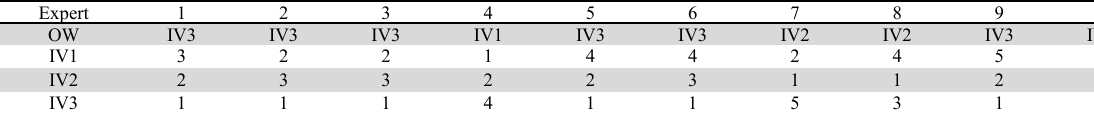
Informational value preferences (Others to worst) Expert